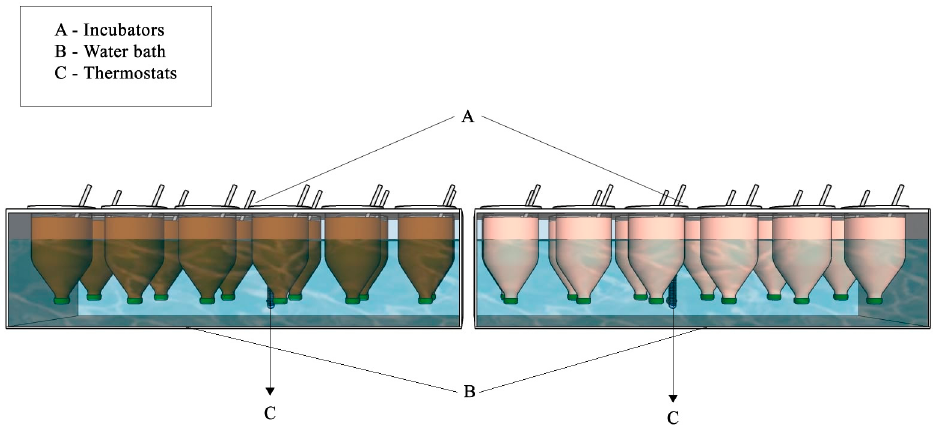
Figure 1. Incubators with both Artemia and